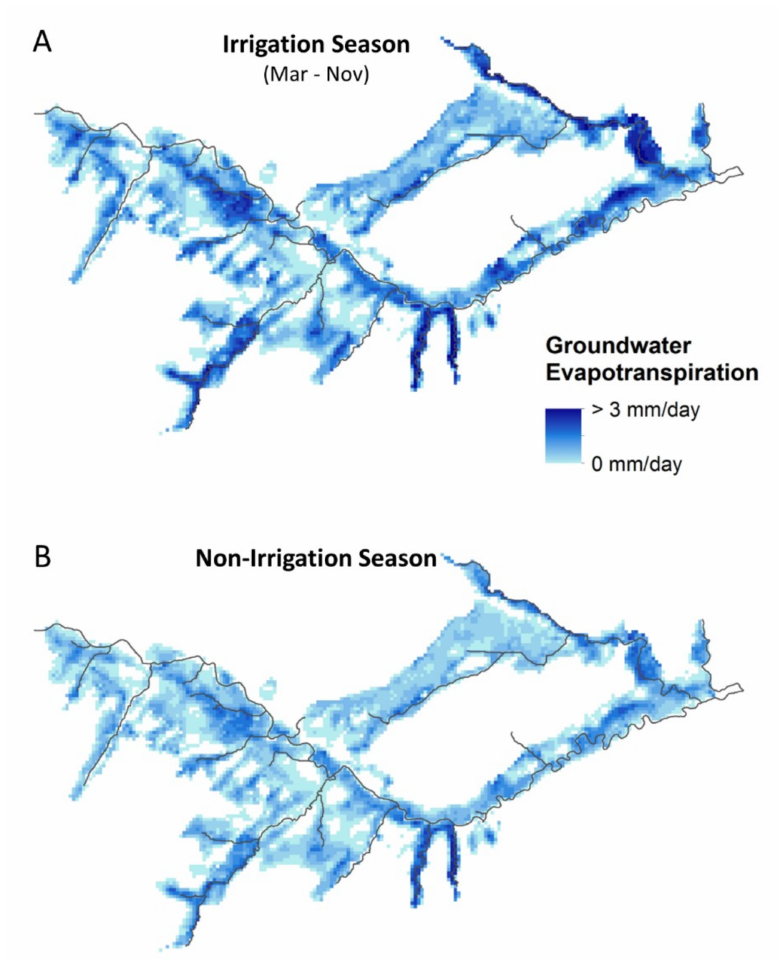
Figure 12. Departure from annual groundwater upflux to ET for the ( A ) irrigation season and ( B ) non-irrigation season over the 1999–2016 time